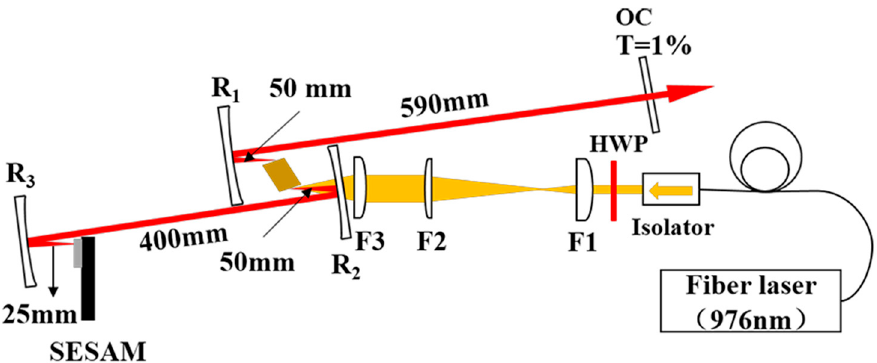
Figure 1. Diagram of the Er:Y 2 O 3 Q-switched and mode locked (QML) laser. HWP: half-wave plate; F1–F3: plane-convex lens; R 1 –R 3 : concave mirrors with the reflectivity of >99.8% at 2650–2950 nm and the transmission of >97% at 965–980 nm; OC: output coupler.